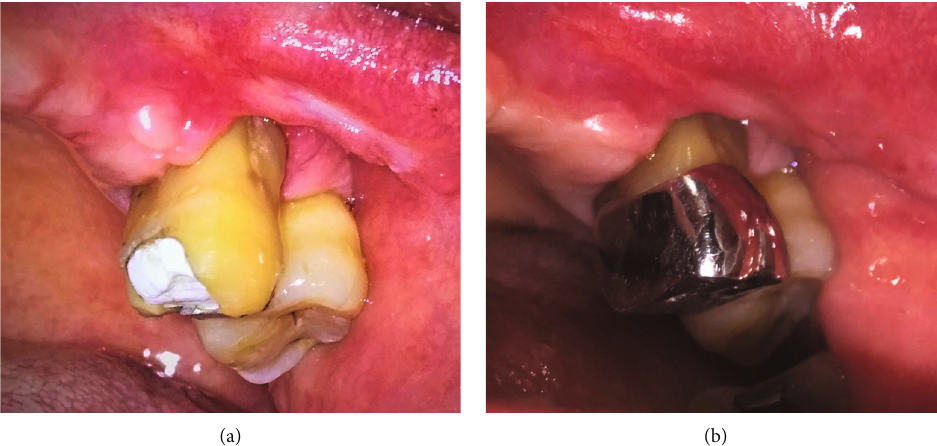
Figure 4: Post-operative condition: (a) One month post-operative: gingival recession was evident, especially on the buccal of tooth #26. (b) Five months post-operative: temporary restoration has been replaced by a metal crown. The gingival margin migrated toward the coronal direction. Scar tissue on mesial of tooth #26 was less noticeable.